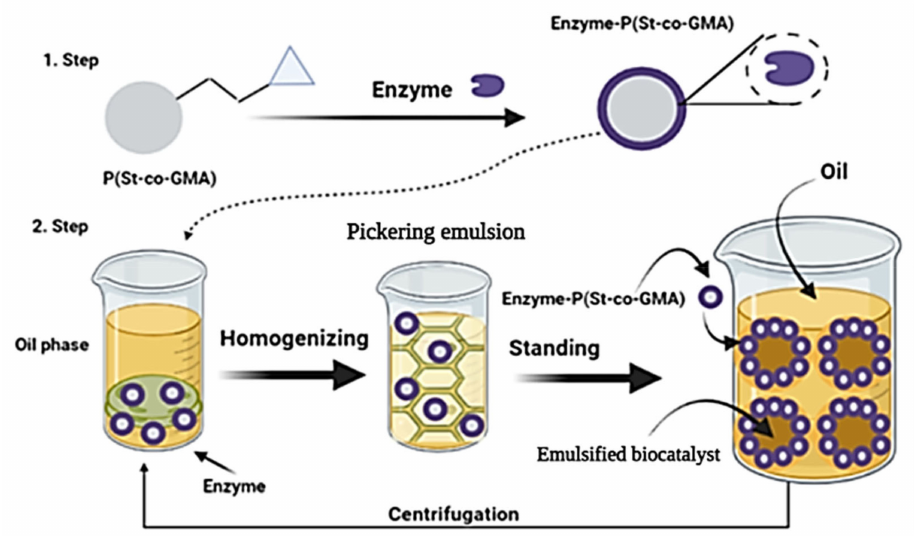
Figure 8. Enzyme-decorated nanoparticle-stabilized Pickering gel emulsion for biphasic biocatalysis or Pickering high internal phase emulsions (HIPEs). In step 1, an enzyme-decorated polymeric nanoparticle is prepared to stabilize oil-in-water HIPEs by emulsion copolymerization without a styrene surfactant and glycidyl methacrylate. Then, the second step is adding the Pickering gel system of the enzyme decorated in the nanoparticle. Then, the emulsion is homogenized to increase the interaction of the nanoparticle with the emulsion. Subsequently, standing occurs and finally forms an emulsified biocatalyst using the Pickering